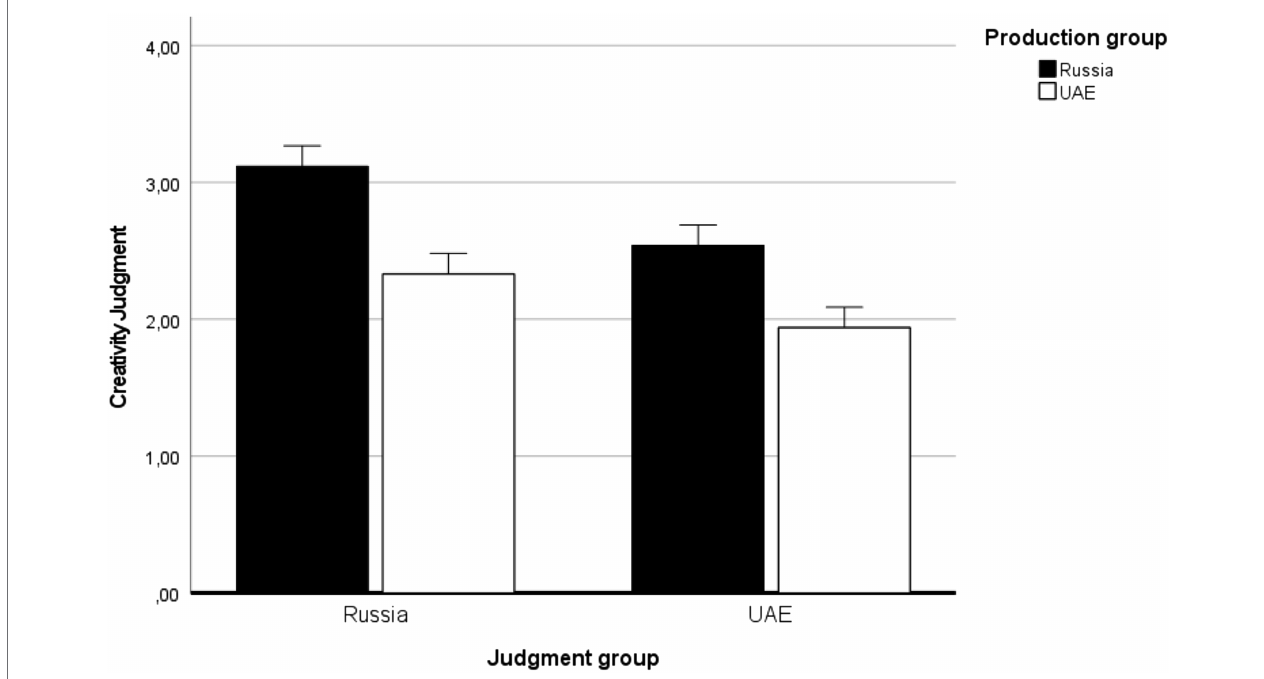
FIGURE 2 | The Russian and Emirati participants’ judgments (Phase II) of the Invented Alien Creature drawings produced by Russian and Emirati participants (Phase